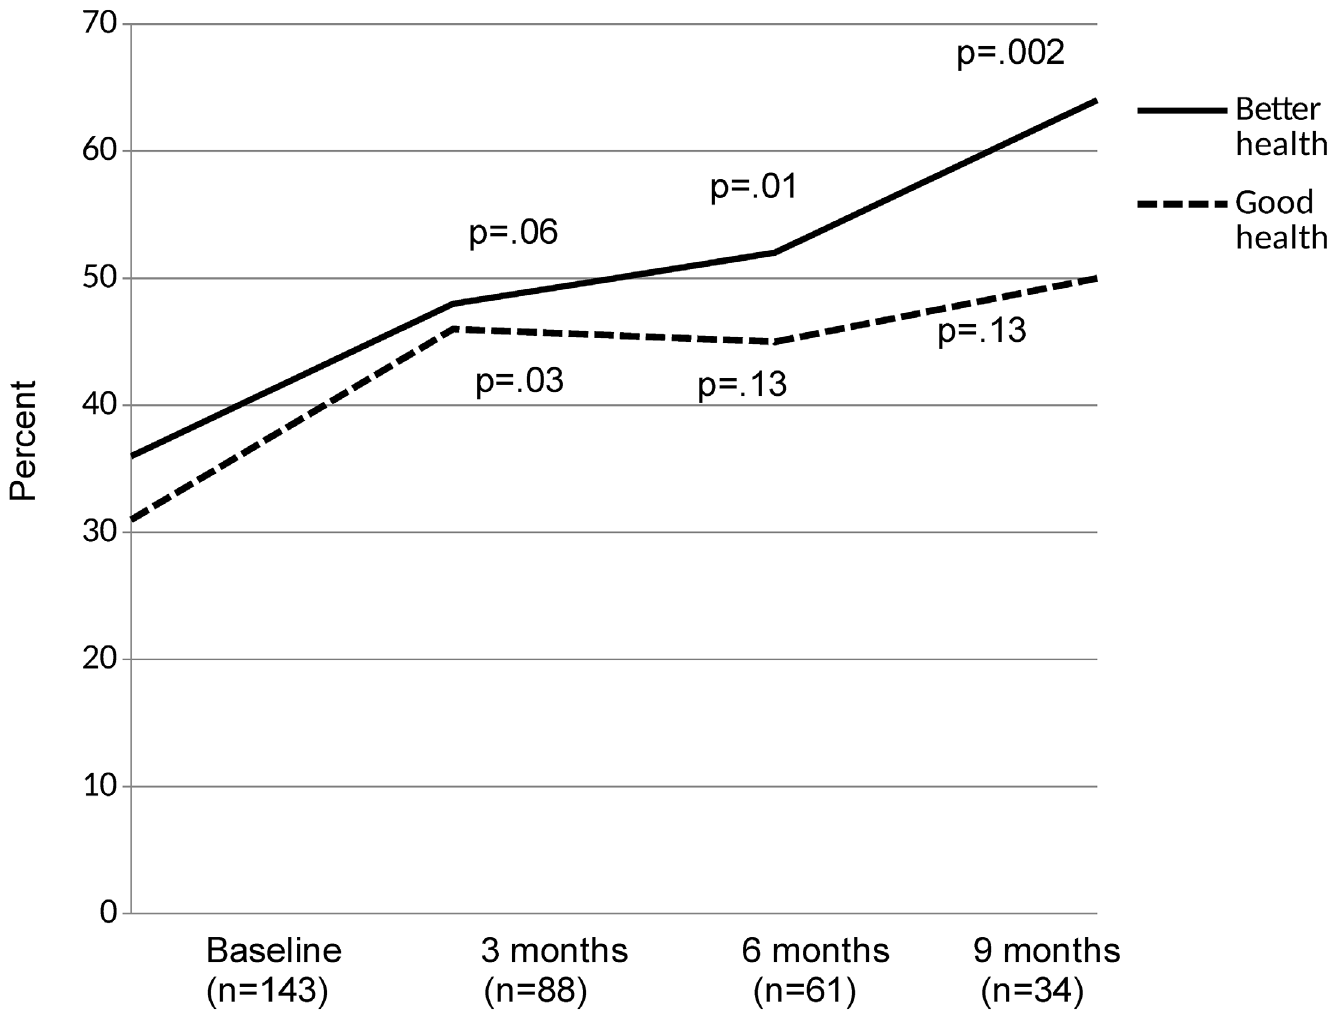
Fig 4. Changes in Self-Rated Health in Care Support Patients Over Time. The percentage of patients who self-reported good health (defined as good, very good or excellent versus fair or poor) is shown in red, while the percentage of patients who self-reported that their health was better than 3 months ago (defined as somewhat or much better versus about the same, somewhat worse or much worse) is shown in blue. P-values are based on McNemar ’ s test for paired proportions compared to baseline